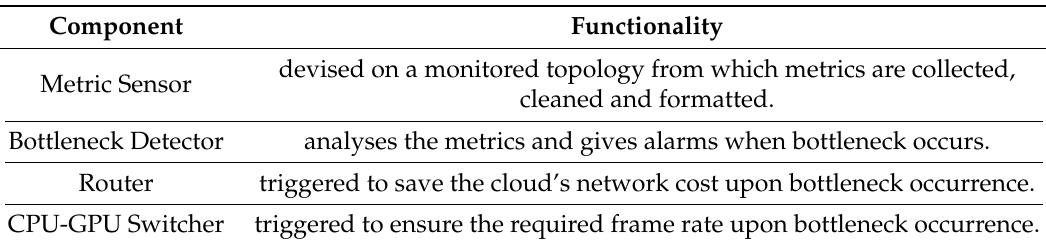
Table 1. Component functionality